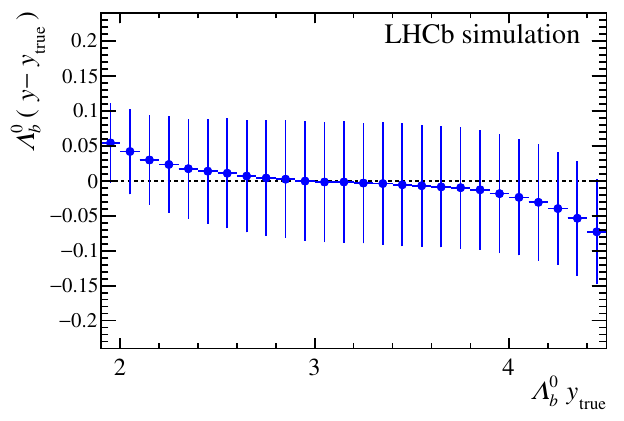
Figure 1 . Mean and the standard deviation of the difference of reconstructed and true rapidity of baryons as a function of the true rapidity obtained from simulation. The reconstructed rapidity (cid:3) 0 b y is approximated by the rapidity of the (cid:3) + (cid:22) (cid:0) system. The markers correspond to the means and c the error bars correspond to the standard deviations of the distributions in a y true interval.